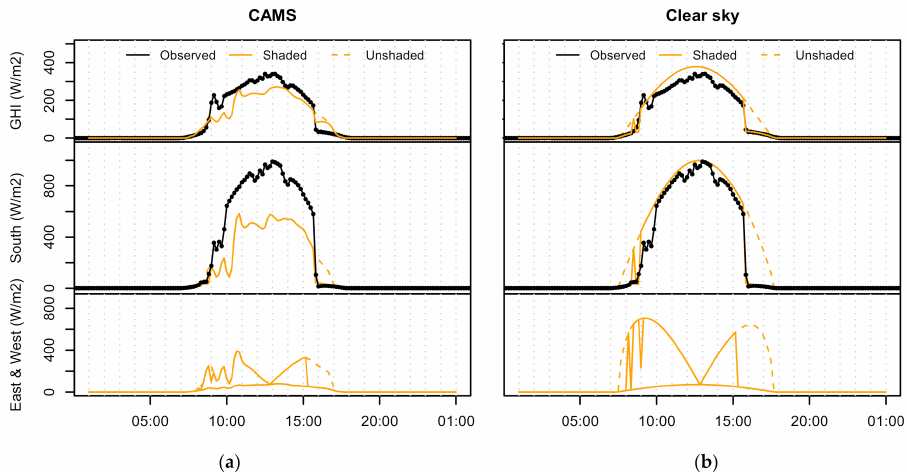
Figure 16. Observed global horizontal (GHI) and total vertical irradiance measured from south sensor position, ZEB Living Lab, NTNU campus compared to the calculated surface irradiances using the CAMS radiation service as input. The CAMS-Rad irradiance over-evaluates cloud cover ( a ) and clear sky ( b